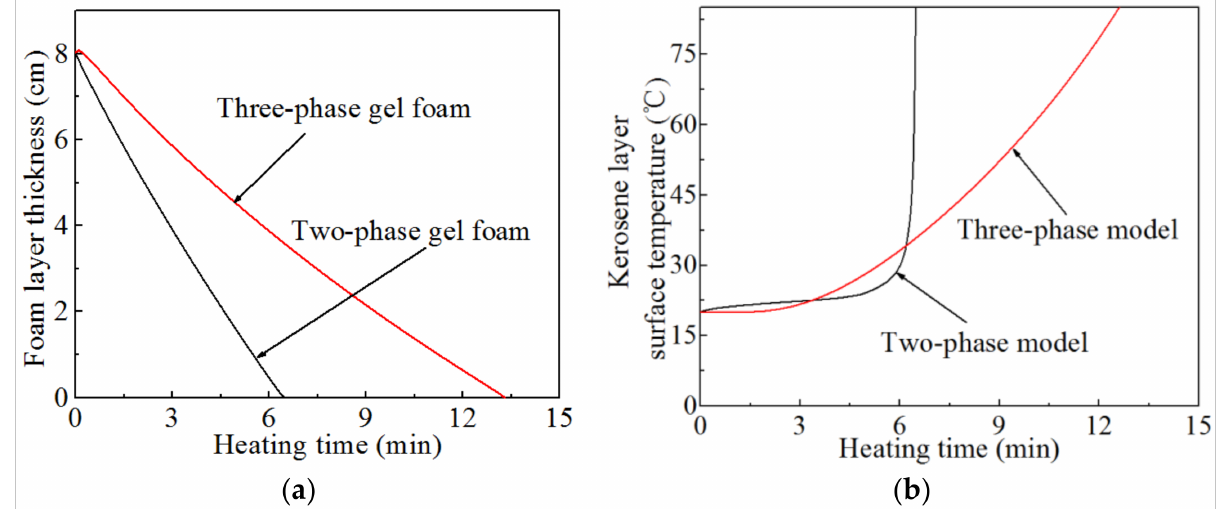
Figure 3. Comparison of the thermal stability and insulation of the two-phase and three-phase gel foam layer under the typical heating conditions. ( a ) Thickness change in the gel foam layer. ( b ) Surface temperature change in the kerosene layer.